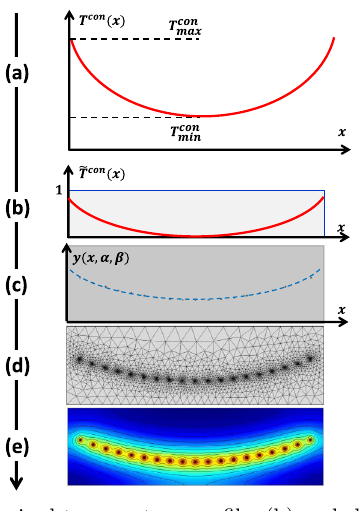
Fig. 3. (a) Desired temperature pro fi le, (b) scaled temperature curve, (c) parametric curve de fi ning the position of the sources in the plate, (d) fi nite element model with heating sources and (e) simulated temperature fi eld within the press plate.